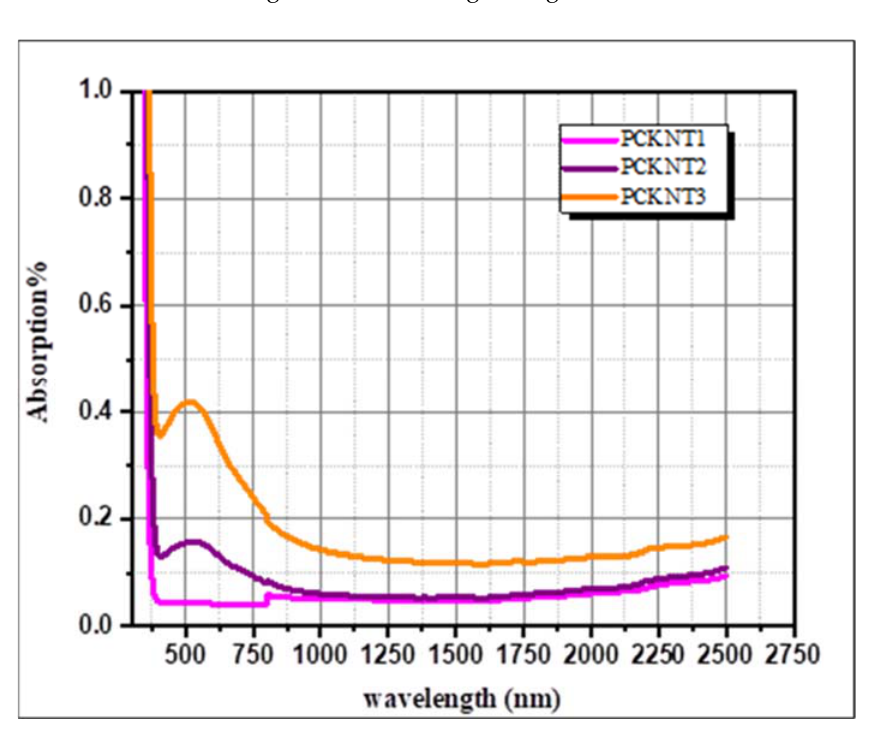
Figure 1. Absorbance spectroscopy for different compositions of PCKNT.